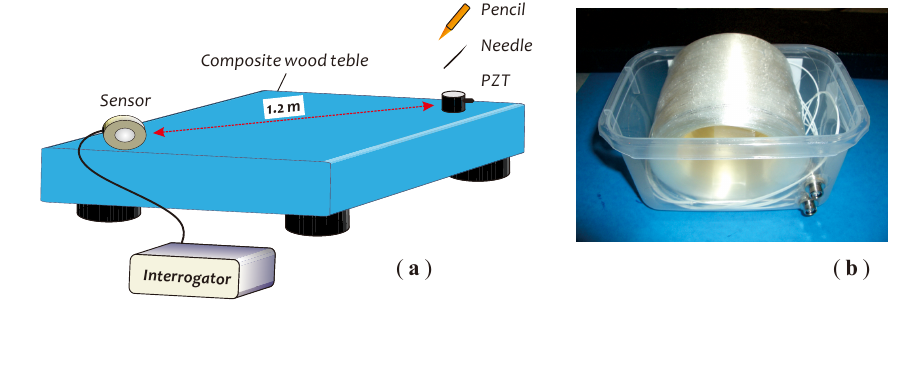
Figure 11. Schematic of the test platform ( a ) used for sensor performance evaluations; ( b ) a photo of the fiber sensor head used in the experiments. PZT, piezoelectric transducer.